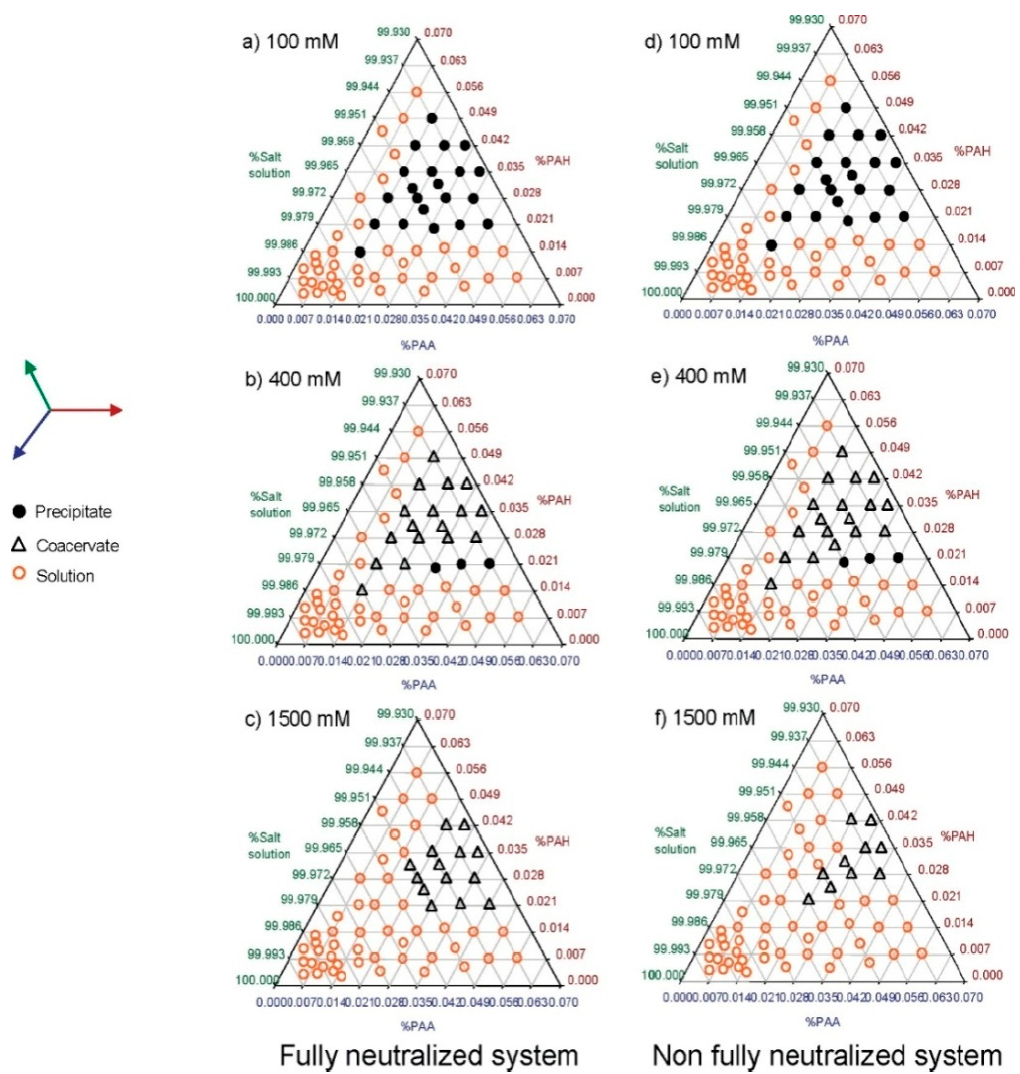
Figure 1. Ternary phase diagrams of PAA/PAH mixtures (0.05 wt% total polymer concentration) in aqueous NaCl salt solution (100, 400, and 1500 mM); fully neutralized system: PAANa solution of pH = 8.6 employed ( a – c ); partially (not fully) neutralized system: PAA solution of pH = 7 employed ( d – f ). Reprinted with permission from Macromolecules , 2010, 43, 2518. Copyright 2010 American Chemical Society.